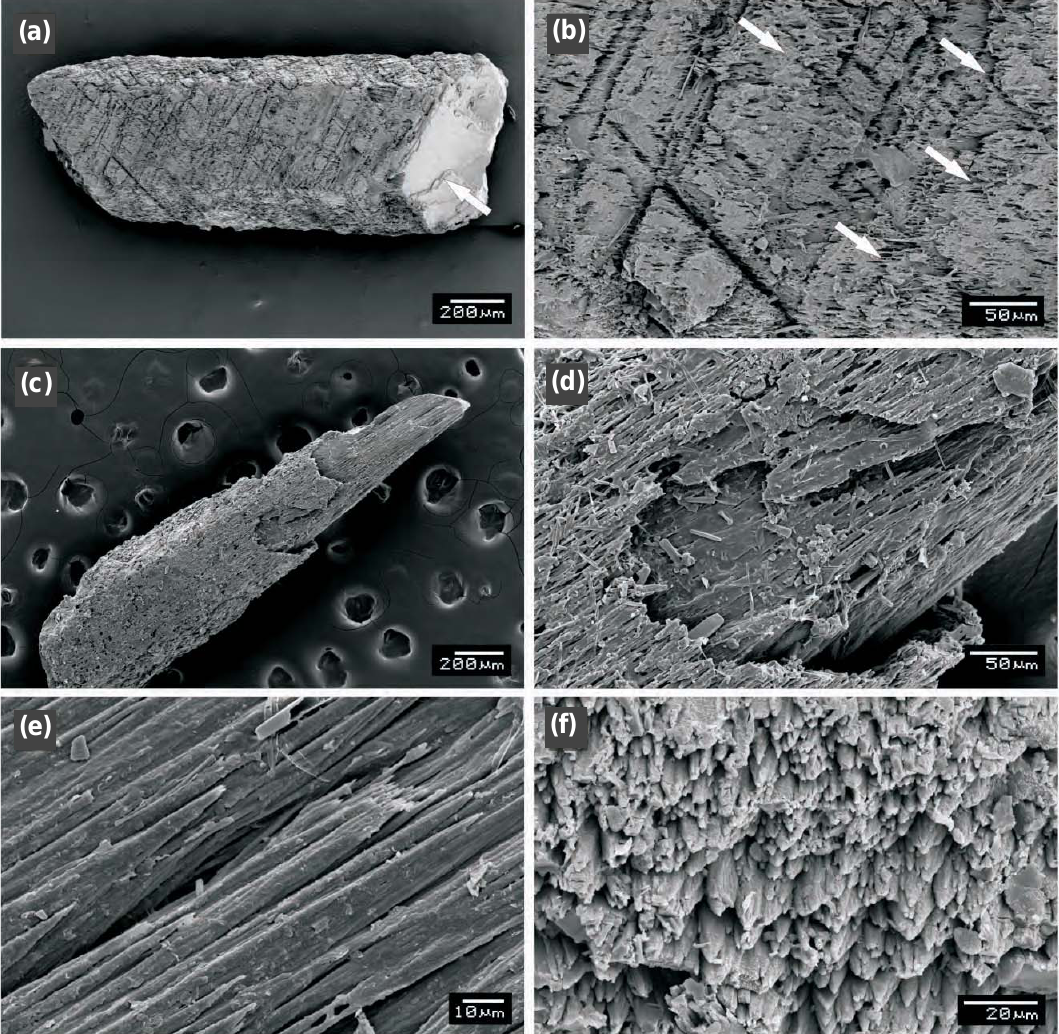
Figure 9. SEM macrographs showing the morphology of calcium carbonate spicules. Spicules were washed away from the living tissue and collected directly from the surface of biofilms, although residence time on the bottom cannot be determined. (a) Calcareous spicule showing specific surface texture (“worn surface”). The spicule shows crystal facets on the surface and cleavage (crystallographic structural planes) in the interior (arrowed) – i.e. typical characteristics of calcium carbonate monocrystal. (b) Detail of previous image; two parallel systems of deep furrows on the surface are crystallographic structural planes of calcite monocrystal; remnants of a superficial layer of microcrystalline calcite are, however, preserved in places on the surface of the crystal (arrowed). (c–f) Another type of spicule, formed mainly by microcrystalline calcite: (c) lateral view of the spicule, (d) detail of the surface showing needle-like calcite microcrystals with distinct layering, (e) parallel needle-like calcite microcrystals on the surface of the central part of the spicule, (f) tops of parallel needle-like calcite microcrystals on the surface of the terminal part of the spicule; the view is perpendicular with respect to the previous